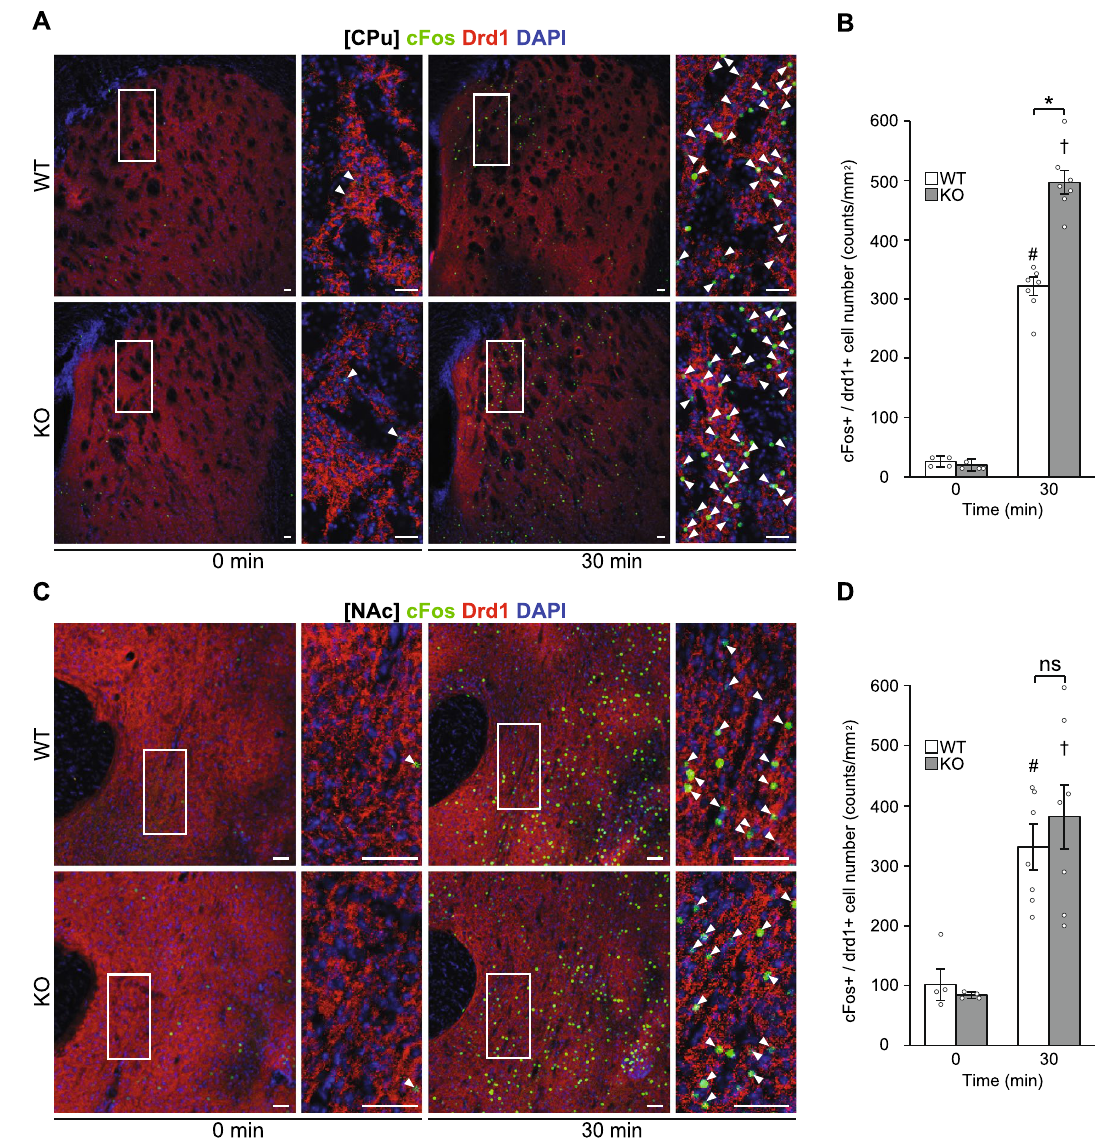
Figure 3. GABA B R deficiency in striatum neurons increases expression of cFos + /drd1 + cells in CPu neurons. ( A and C ) Representative photographs showing the staining of cFos (green), dopamine receptor d1 (drd1) (red), and DAPI (blue) in the caudate putamen (CPu) ( A ) and nucleus accumbens (NAc) ( C ) of wild-type (WT) and knockout (KO) mice in the binge group. White arrowheads show the colocalization of cFos and drd1. Scale bars: 50 μm. ( B and D ) cFos-positive cells in drd1-positive neurons (cFos + /drd1 +) in the CPu ( B ) and NAc ( D ) of WT and KO mice in the binge group. All values are mean ± SEM. Statistical analyses were performed using two-way factorial analysis of variance (ANOVA) followed by Sidak’s post-hoc test ( B and D ). ns: not significant. # p < 0.05 versus 0 min in WT mice. † p < 0.05 versus 0 min in KO mice. * p < 0.05 versus WT mice. See also Supplemental Table 2 for details on